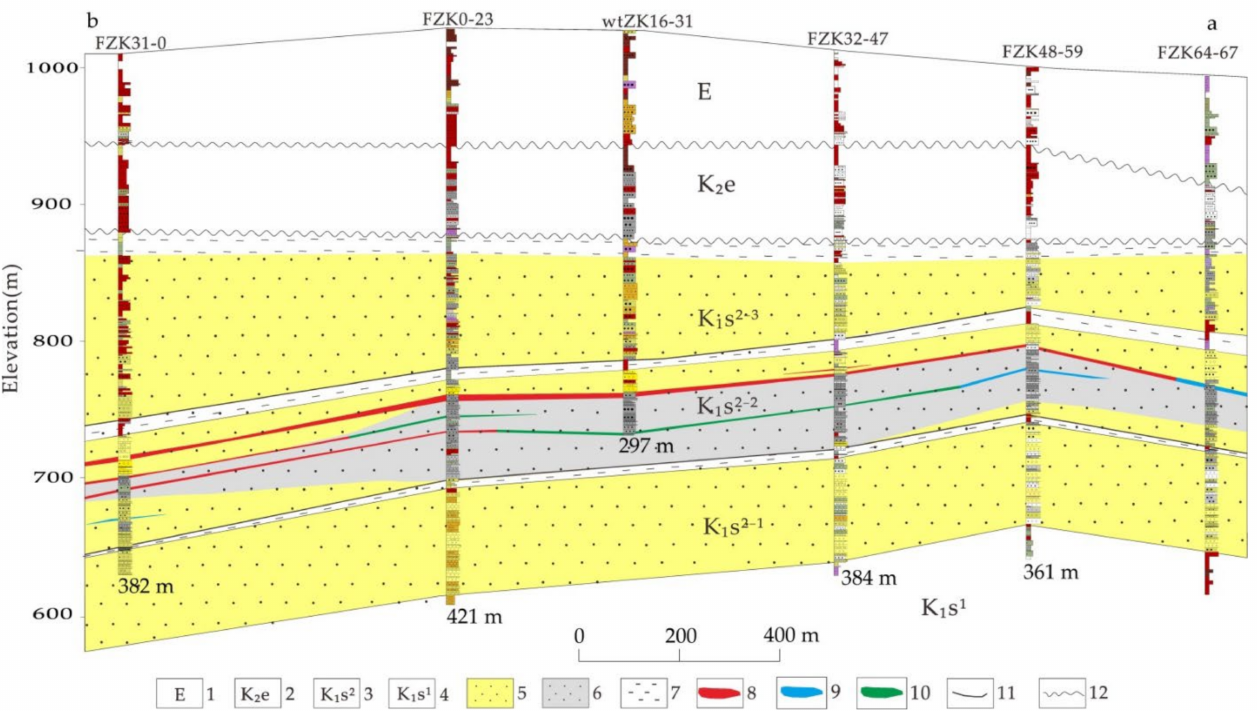
Figure 10. Geological profile of a–b in the Hadatu uranium deposits. 1—Paleogene strata. 2—Erlian group. 3—Upper part of Saihan group. 4—Bottom part of Saihan group. 5—Yellow oxidized sands. 6—Gray reducing sands. 7—Mudstone. 8—Uranium ore bodies. 9—Uranium mineralization. 10—Uranium abnormal. 11—Lithologic boundary. 12—Non-conformity